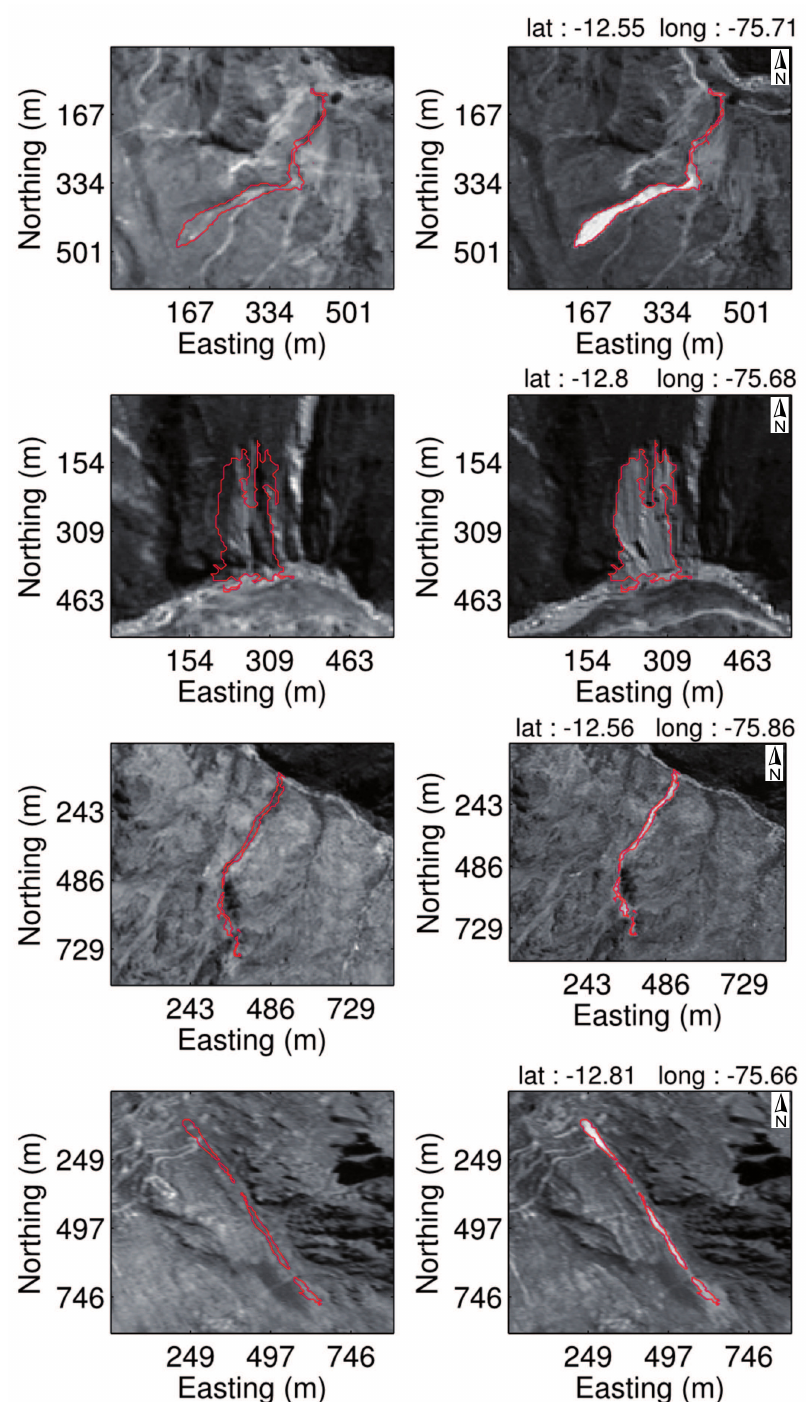
Figure 9. Example of landslides detected by the methodology. Left and right subplots correspond to pre- and post-event images